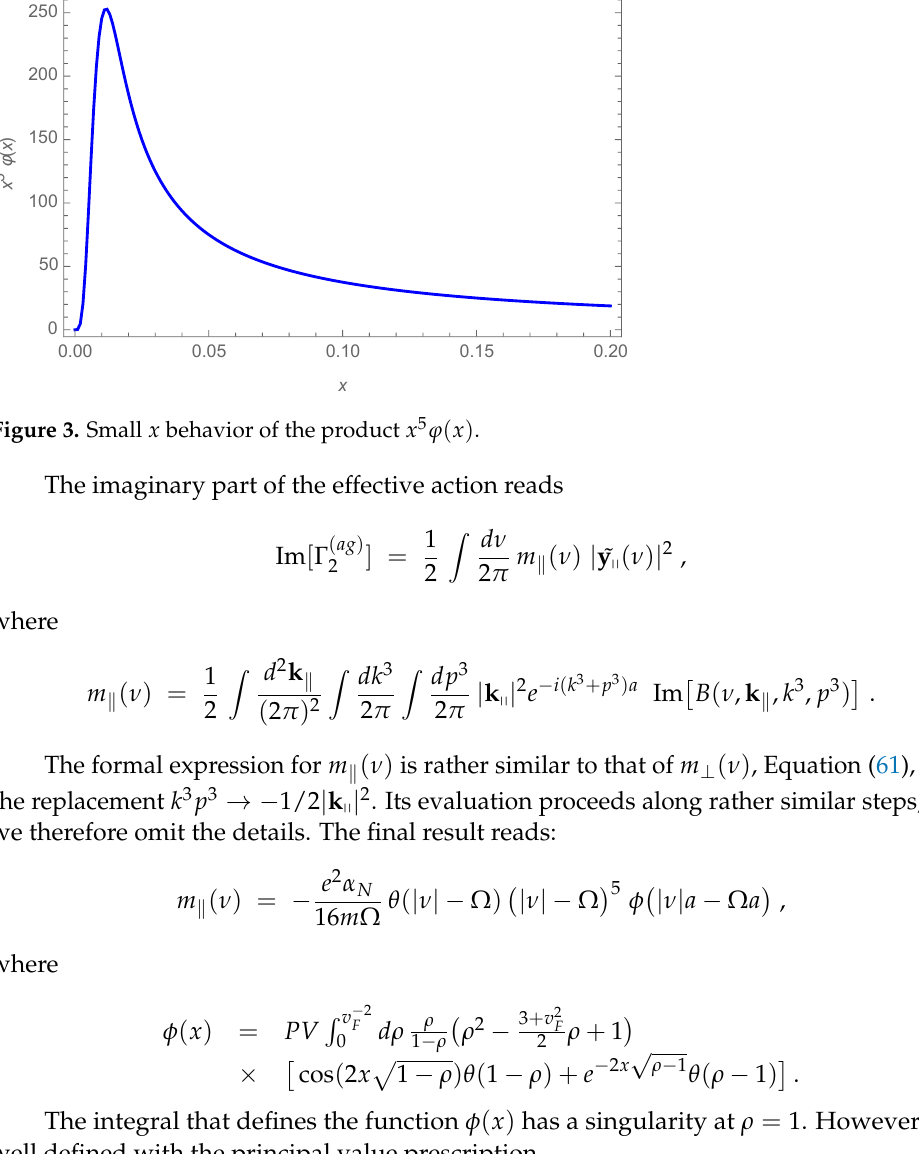
Figure 2. Dimensionless function ϕ as a function of x = a